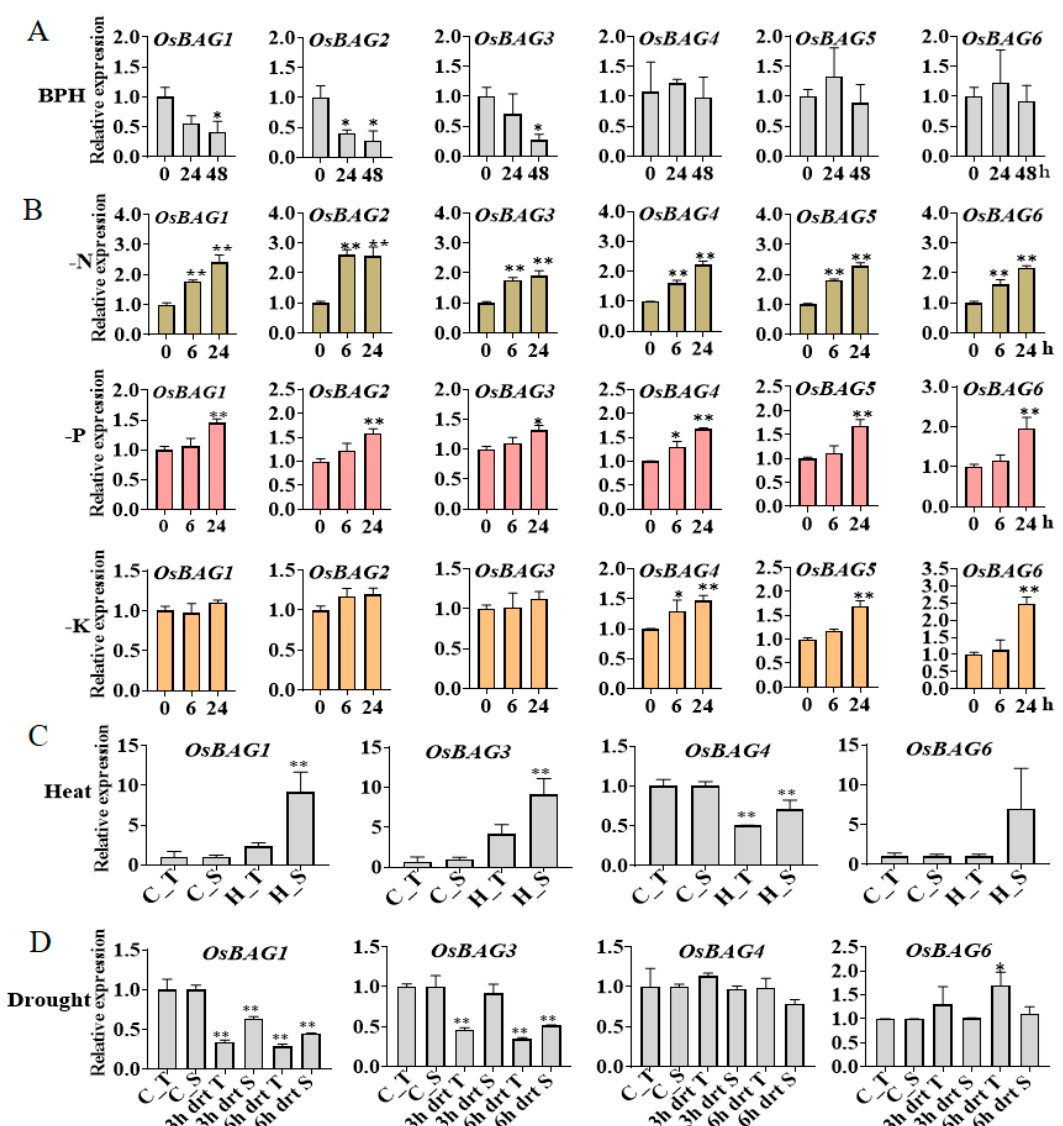
Figure 5. Expression patterns of OsBAGs in responses to environmental stimulations. ( A ) Gene expression profiles of rice in response to brown planthopper (BPH). The expression patterns of OsBAG genes were analyzed by real-time qPCR. The 14-day-old rice seedlings were treated with the BPH feeding from 0 to 48 h. n = 5. ( B ) An overview of the expression profiles of all genes in root from rice seedlings under nitrogen (N), phosphorus (P), and potassium (K) deficiency conditions based on the RiceXPro data. The 7-day-old seedlings were exposed to N, P, and K deficiency treatments and control conditions separately. ( C ) Expression data collected from the panicles of both heat-resistant and heat-sensitive rice under high temperature. C_T, control tolerant; C_S, control sensitive; H_T, heat tolerant; H_S, heat sensitive. ( D ) Hydroponically grown seven-day-old seedlings of drought tolerant and susceptible cultivars of indica were subjected to drought stress. C_T, control-tolerant; C_S, control-sensitive; 3 h drt T, 3 h drought-tolerant; 3 h drt S, 3 h drought-sensitive; 6 h drt T, 6 h drought-tolerant; 6 h drt S, 6 h drought-sensitive. The expression data in ( B – D ) based on NCBI GEO DataSets. * and ** indicate the significance at p = 0.05 and p = 0.01 levels by Student’s t test, respectively, and bars represent standard devia- tions.